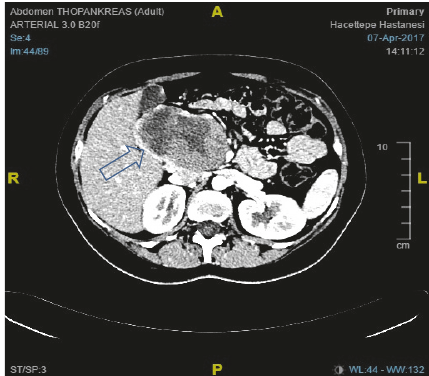
Figure 1: Contrast-enhanced CT of the abdomen showing the mass at the pancreatic head (arrow).